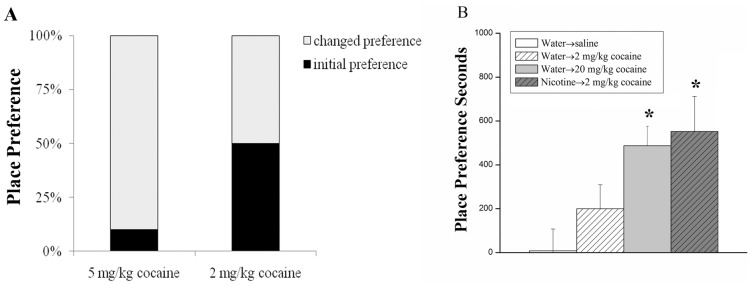
Threshold dose of cocaine-induced CPP is obtained by CPP test and nicotine enhances cocaine-induced CPP (A and B).(A) To explore threshold dose of cocaine-induced CPP, we designed two doses of cocaine (5 mg/kg and 2 mg/kg) to treat mice once a day for 3 days (n = 12 in each group). (B) To detect effects of nicotine on cocaine, four experimental groups were designed (n = 8 for all groups).